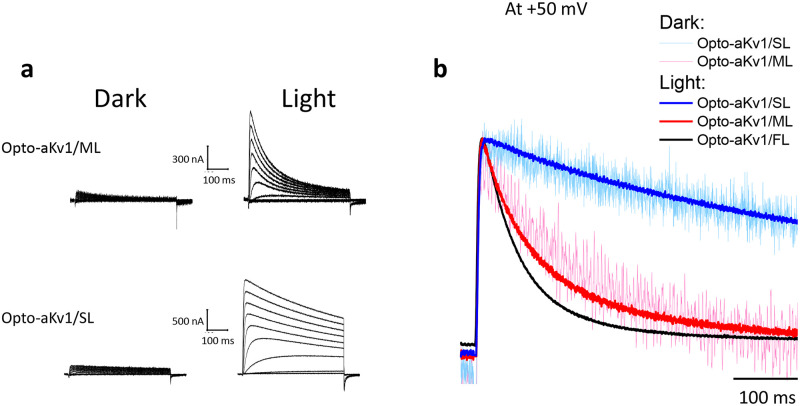
N-terminal variants of Opto-aKv1 show different inactivation kinetics but similar levels of induction with blue light.a) Outward currents expressed by Opto-aKv1/ML and Opto-aKv1/SL elicited by depolarizing pulses as described in Fig 2a. Application of blue light, as observed with Opto-aKv1/FL, dramatically induced surface expression of Opto-aKv1/ML and Opto-aKv1/SL. b) Overlapped traces of Opto-aKv1/FL, Opto-aKv1/ML, and Opto-aKv1/SL at +50 mV with blue light treatment.